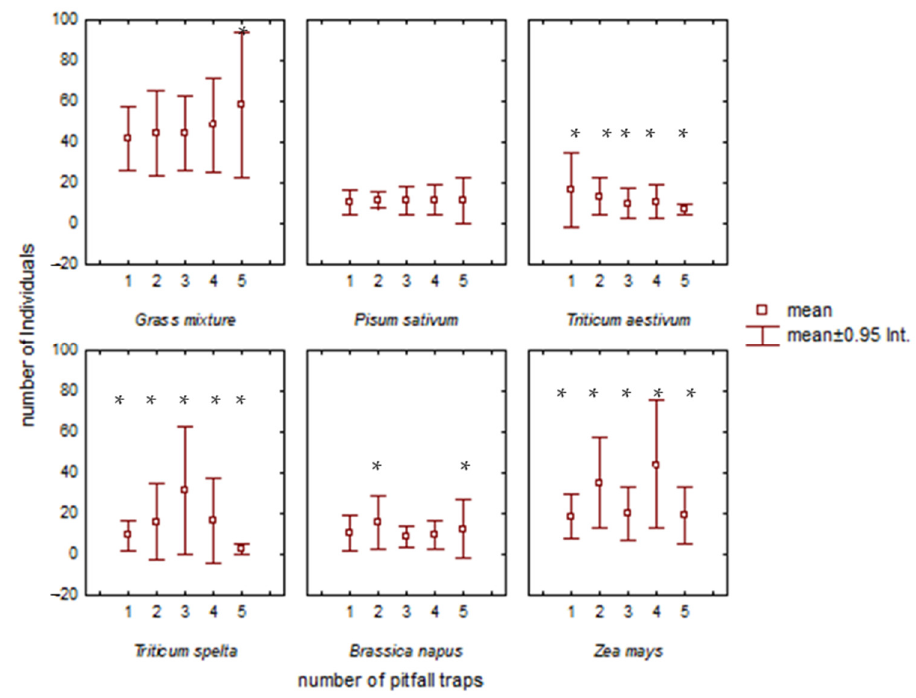
Figure 5. Mean numbers of individuals (±95% Confidence Interval, CI) in pitfall traps located in the ecotones (traps 1 and 2) and in the fields (traps 3, 4, 5). Significant impact (*).